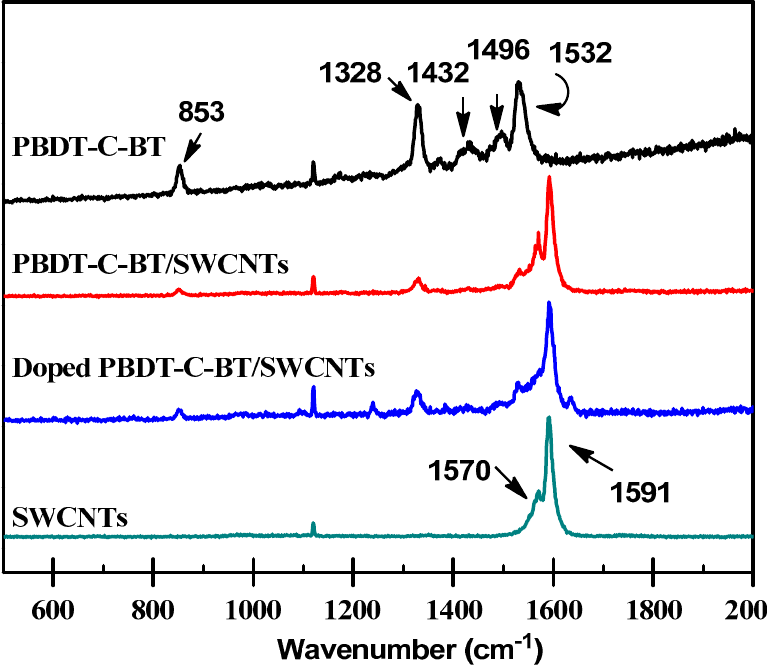
Figure 2. Raman spectra of PBDT–C–BT, SWCNTs, PBDT–C–BT / 50 wt % SWCNTs and / F 4 TCNQ doped PBDT–C–BT / 50 wt %